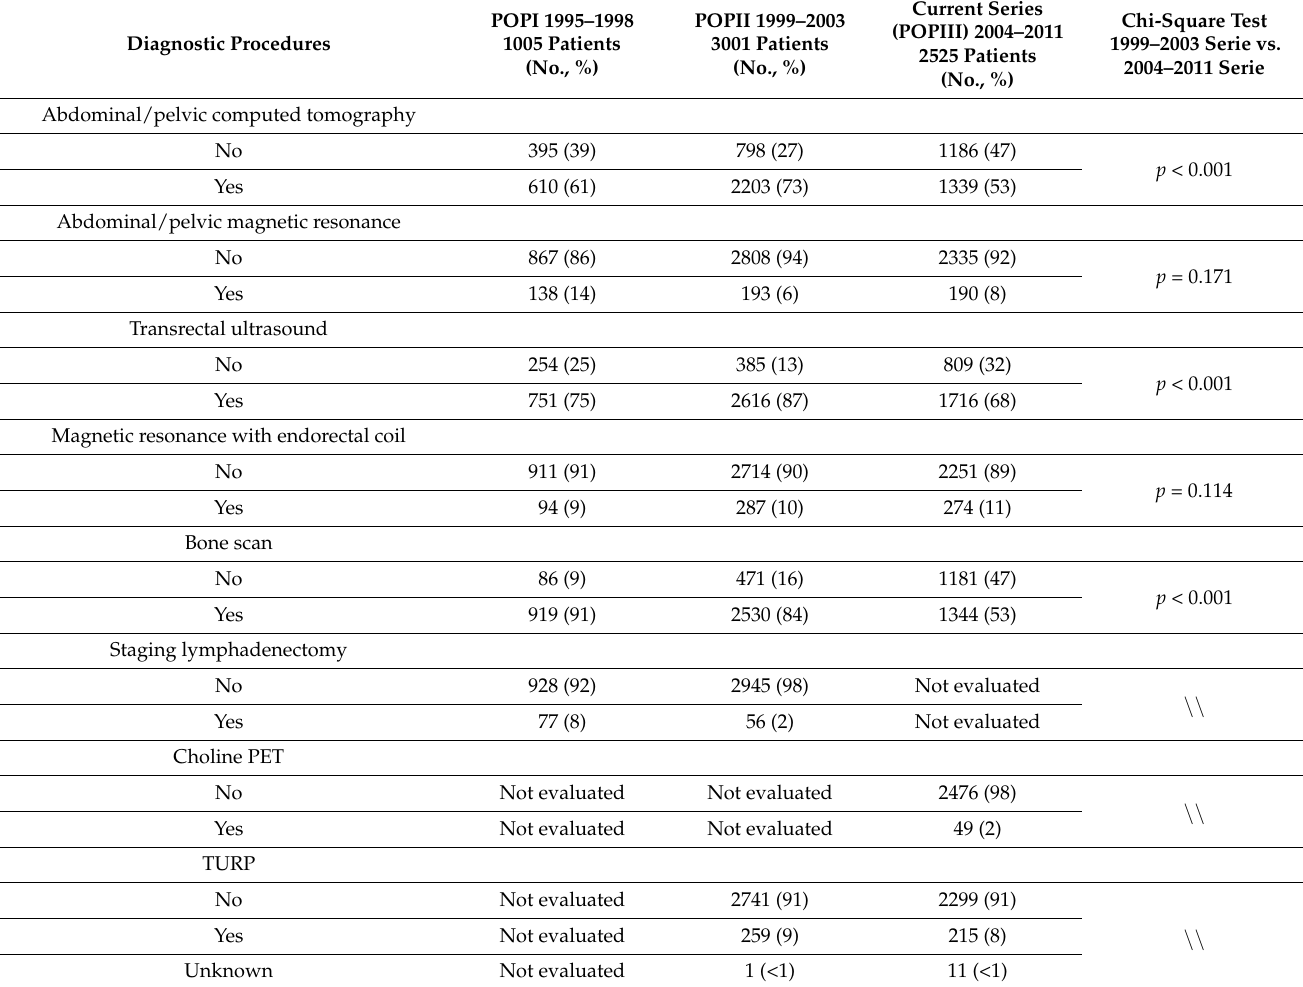
Table 2. Diagnostic procedures adopted in the three subsequent